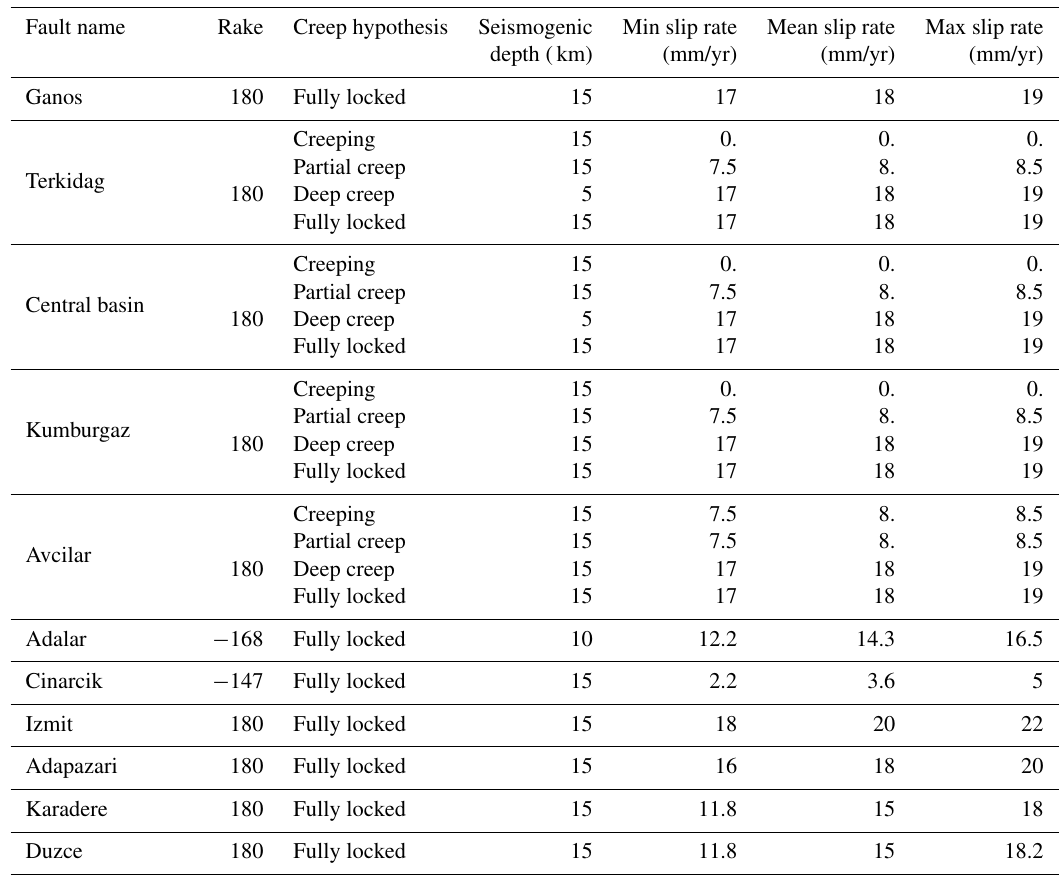
Table 1. Model parameters of the faults of the Marmara Region, closer to Istanbul. The full parameter table for all the faults in the model is available in the electronic Supplement. See the text for details on slip-rate setting and definition of partial and deep creep.